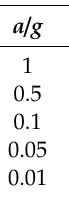
ff erent time steps (experimental data from Sarpkaya and Garrison [16]). Figure 7. Comparison of different time steps (experimental data from Sarpkaya and Garrison [16]) Figure 7. Comparison of di